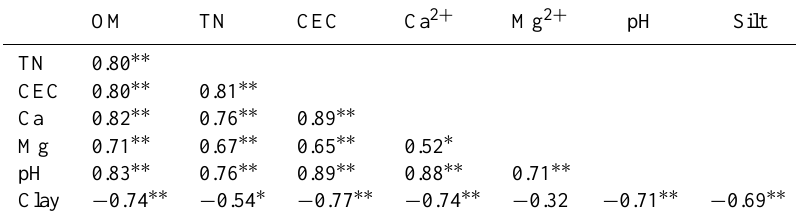
Table 5. The correlation matrix for selected soil properties at 0–15cm depth in northeastern Wellega, Ethiopia. OM TN CEC Ca 2 + Mg 2 + pH